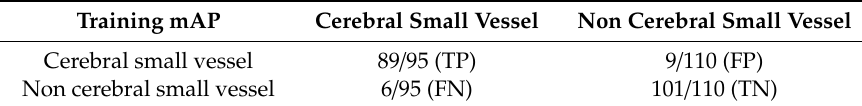
Table 7. Training mAP of YOLO3 model.